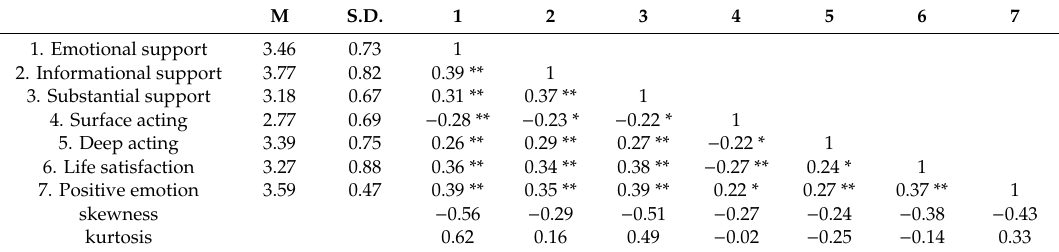
Table 2. Means, standard deviations, correlations, and reliability among the study variables.